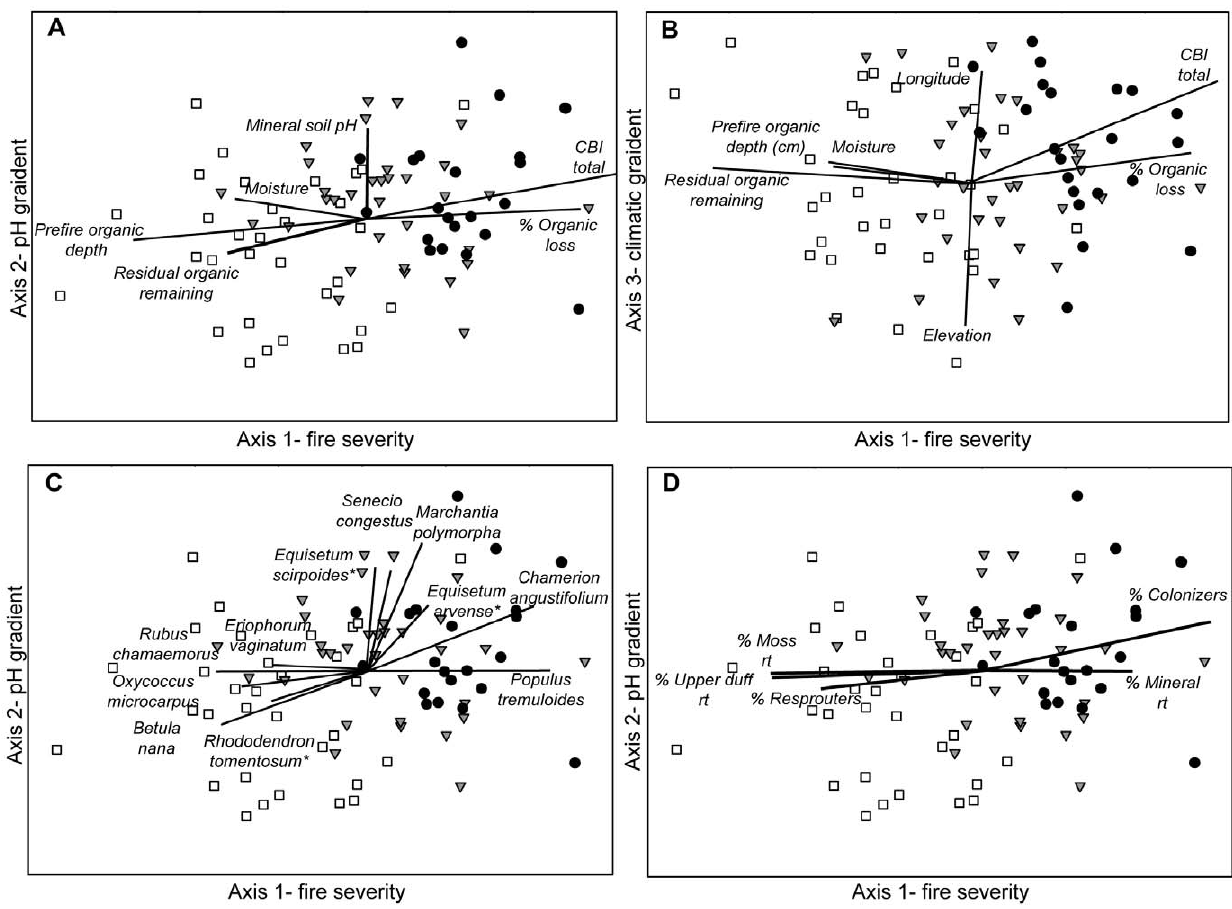
N =high severity sites, . =moderate severity, and % =low severity Figure 2. NMDS ordinations of all sites. Sites are grouped by fire severity ( sites), showing Axis 1 versus Axis 2 (a, c, d) and Axis 1 versus Axis 3 (b). Strong correlations (r . 0.25) with the ordination axes are indicated by biplot vector where length and direction represent the magnitude and direction of correlation, respectively. Ordination axes were correlated with abiotic and biotic environmental variables (a,b), species composition (c), and plant trait composition (d). Axis 1 represents a fire severity gradient, Axis 2 represents an acidity gradient, and Axis 3 represents a climatic gradient. For ease of interpretation, all vectors are shown at 150% magnitude.